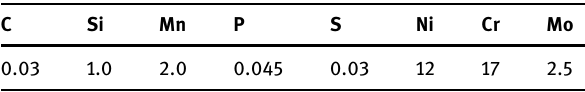
Table 1: Composition of 316 stainless steel ( wt% )